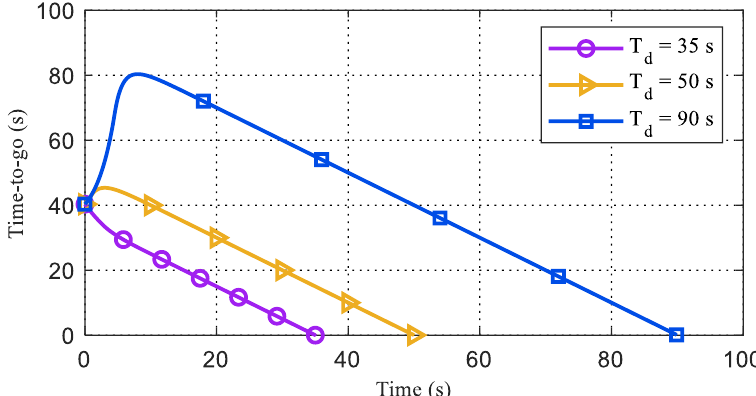
Figure 5. Time-to-go without look angle constraints.